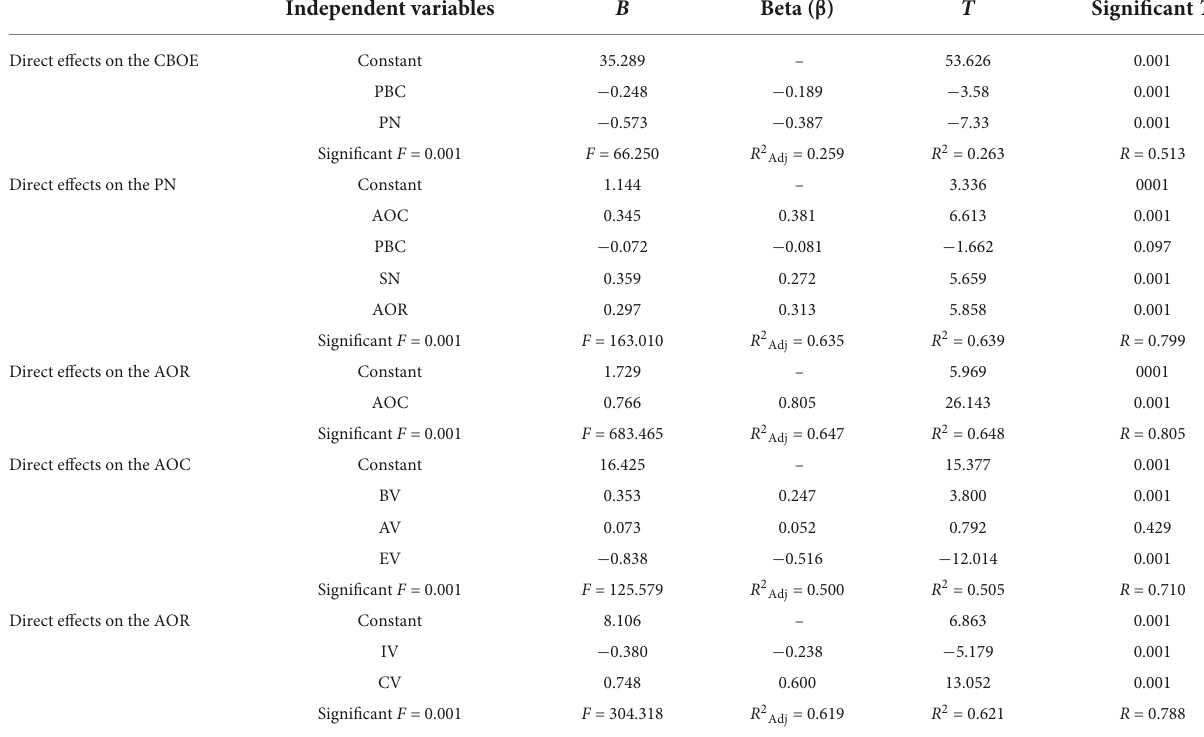
TABLE 5 Calculation of direct effects on CBOE, PN, AOR, and